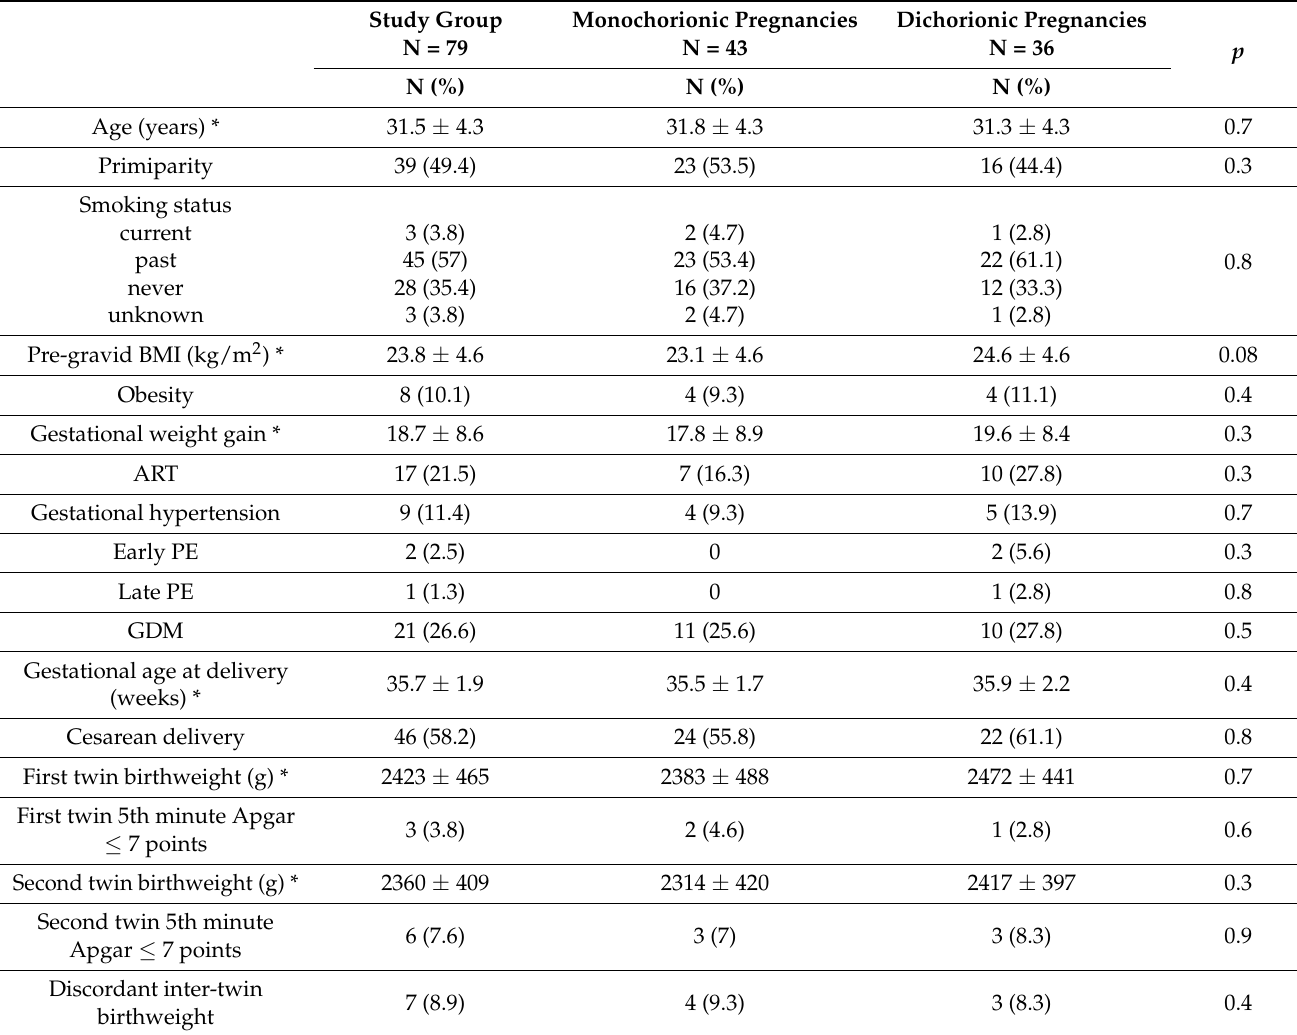
Table 1. Basic characteristics of the study